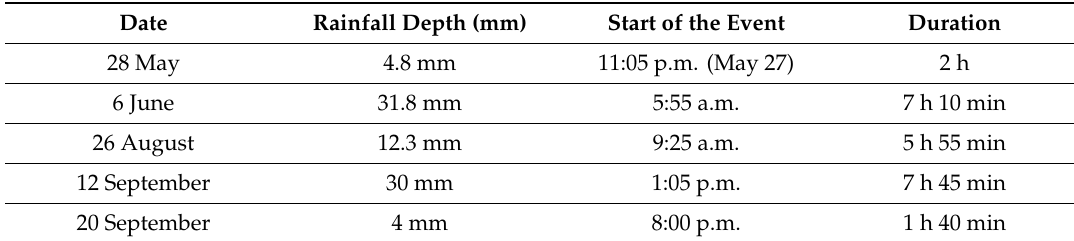
Table 2. Rainfall data of the events in